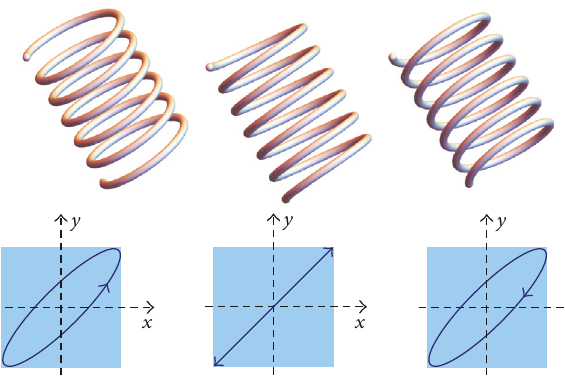
Figure 9: Different projections of rotations around a circle produce different